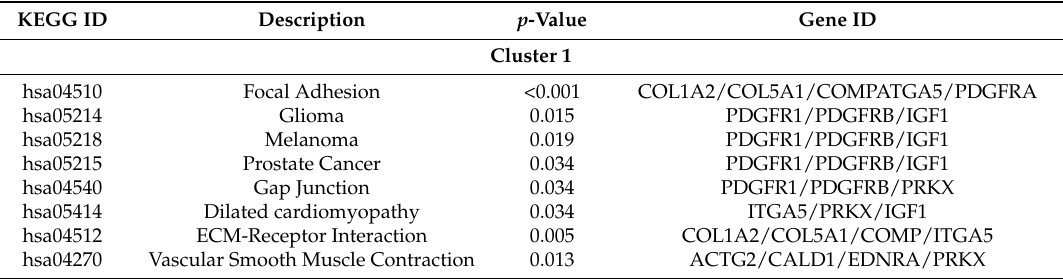
Table 2. Pathway Enrichment Analysis. Given a list of genes, the pathway enrichment analysis using the Kyoto Encyclopedia of Genes and Genomes (KEGG) database will select those pathways that are overrepresented in the gene list for each one of the clusters. It will also compute a p -value for the resulting pathways. * Statistically